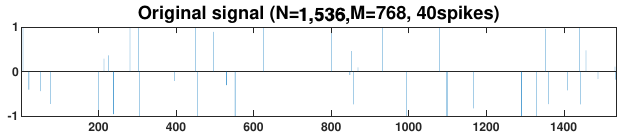
Figure 10. The original signal N = 1024, M = 512 and 20 spikes.